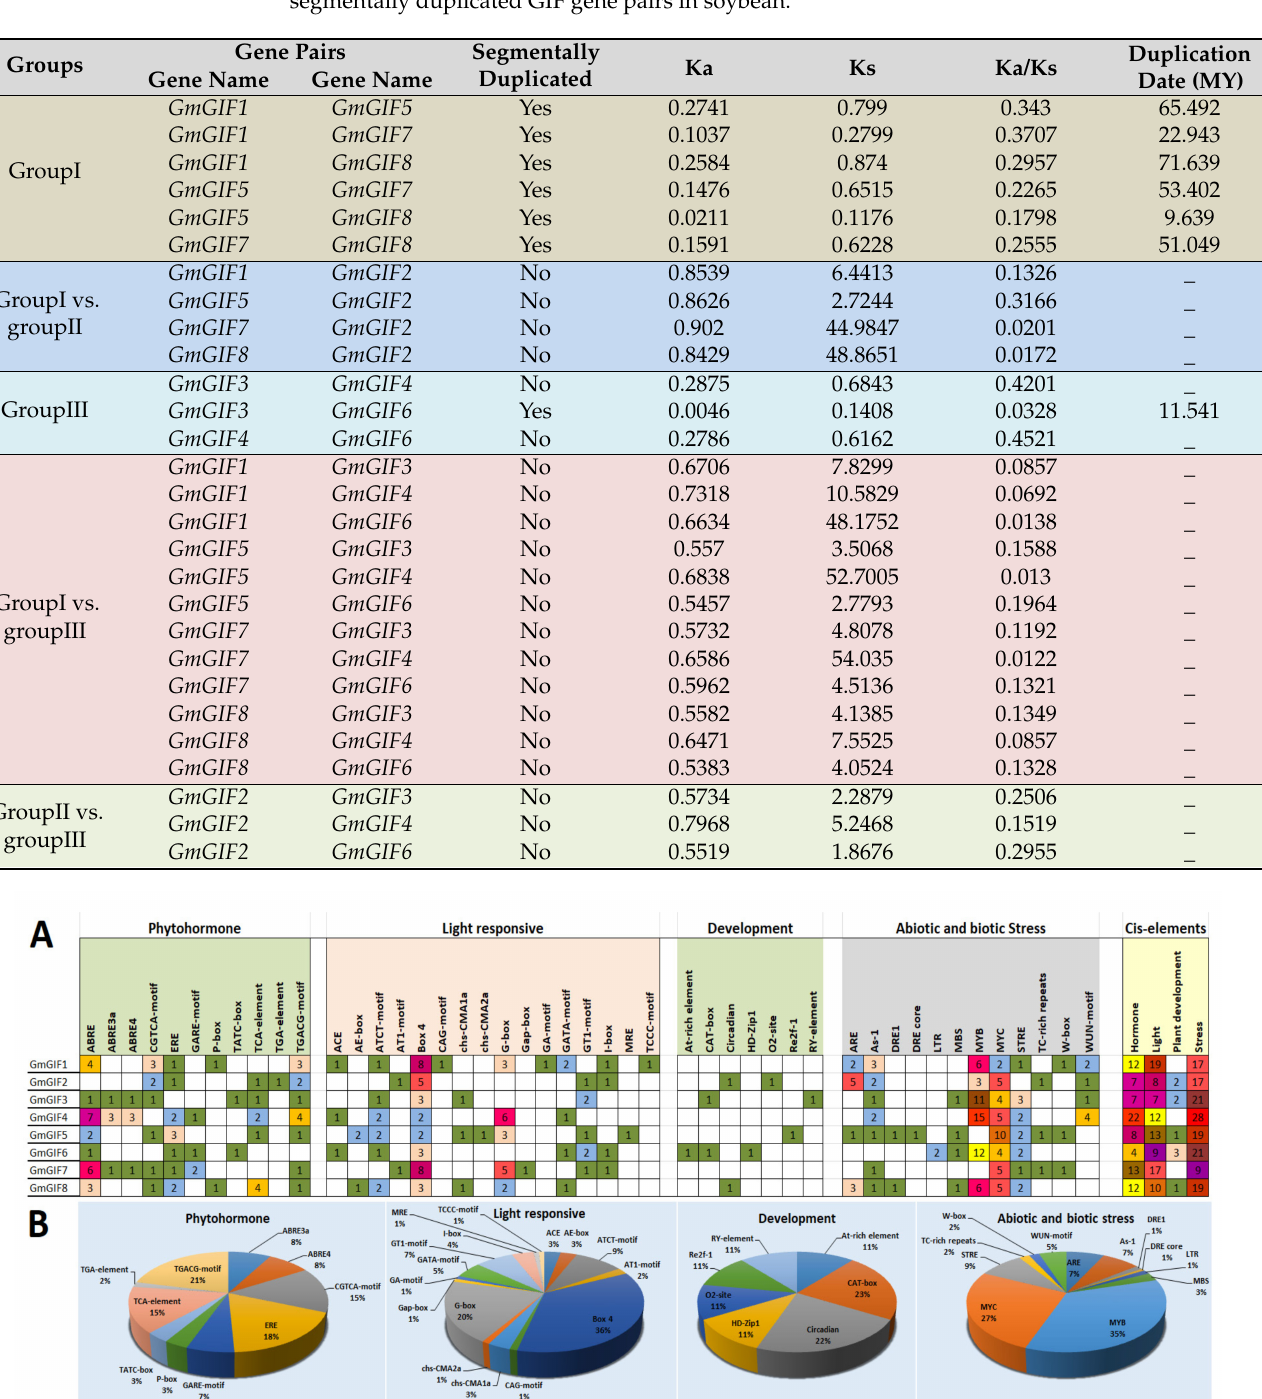
Table 2. The Ka, Ks, and Ka/Ks ratio within group or between groups and divergence time of segmentally duplicated GIF gene pairs in soybean.